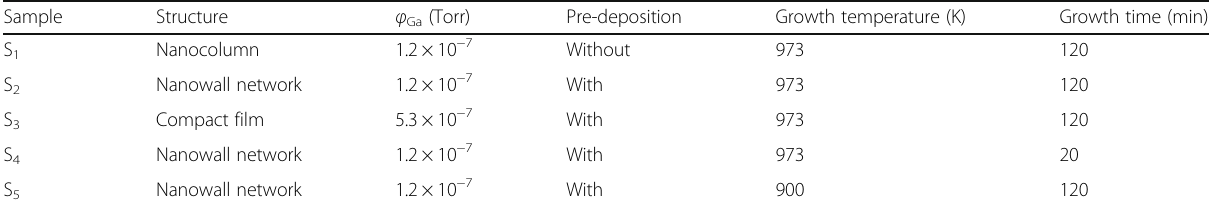
Table 1 Summarization of samples studied in this work Sample Structure φ Ga (Torr) Pre-deposition Growth temperature (K) Growth time (min) S 1 Nanocolumn 1.2 × 10 − 7 Without 973 120 S 2 Nanowall network 1.2 × 10 − 7 With 973 120 S 3 Compact film 5.3 × 10 − 7 With 973 120 S 4 Nanowall network 1.2 × 10 − 7 With 973 20 S 5 Nanowall network 1.2 × 10 − 7 With 900